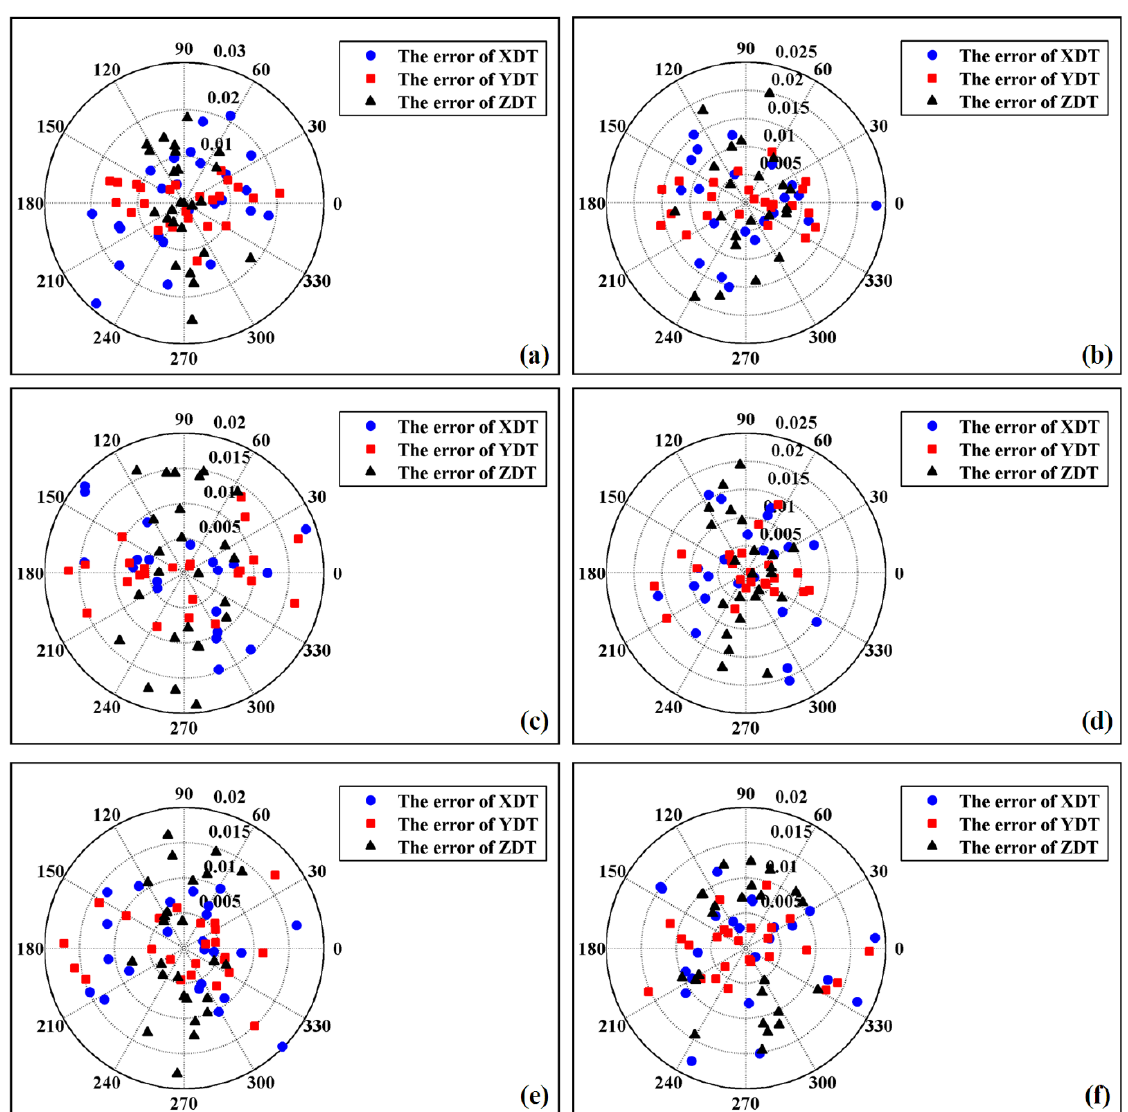
Figure 9. The error distribution of the fitted motion trajectory lines, where XDT = X-direction motion trajectory, YDT = Y-direction motion trajectory, ZDT = Z-direction motion trajectory. Six groups of experiments are designed to analyze the fitting errors under different angle parameters. The distribution of the errors is shown in ( a – f ). ( a ) The error was obtained under 90°; ( b ) The error was obtained under 88.578°; ( c ) The error was obtained under 87.137°; ( d ) The error was obtained under 85.683°; ( e ) The error was obtained under 84.213°; ( f ) The error was obtained under 82.728°.